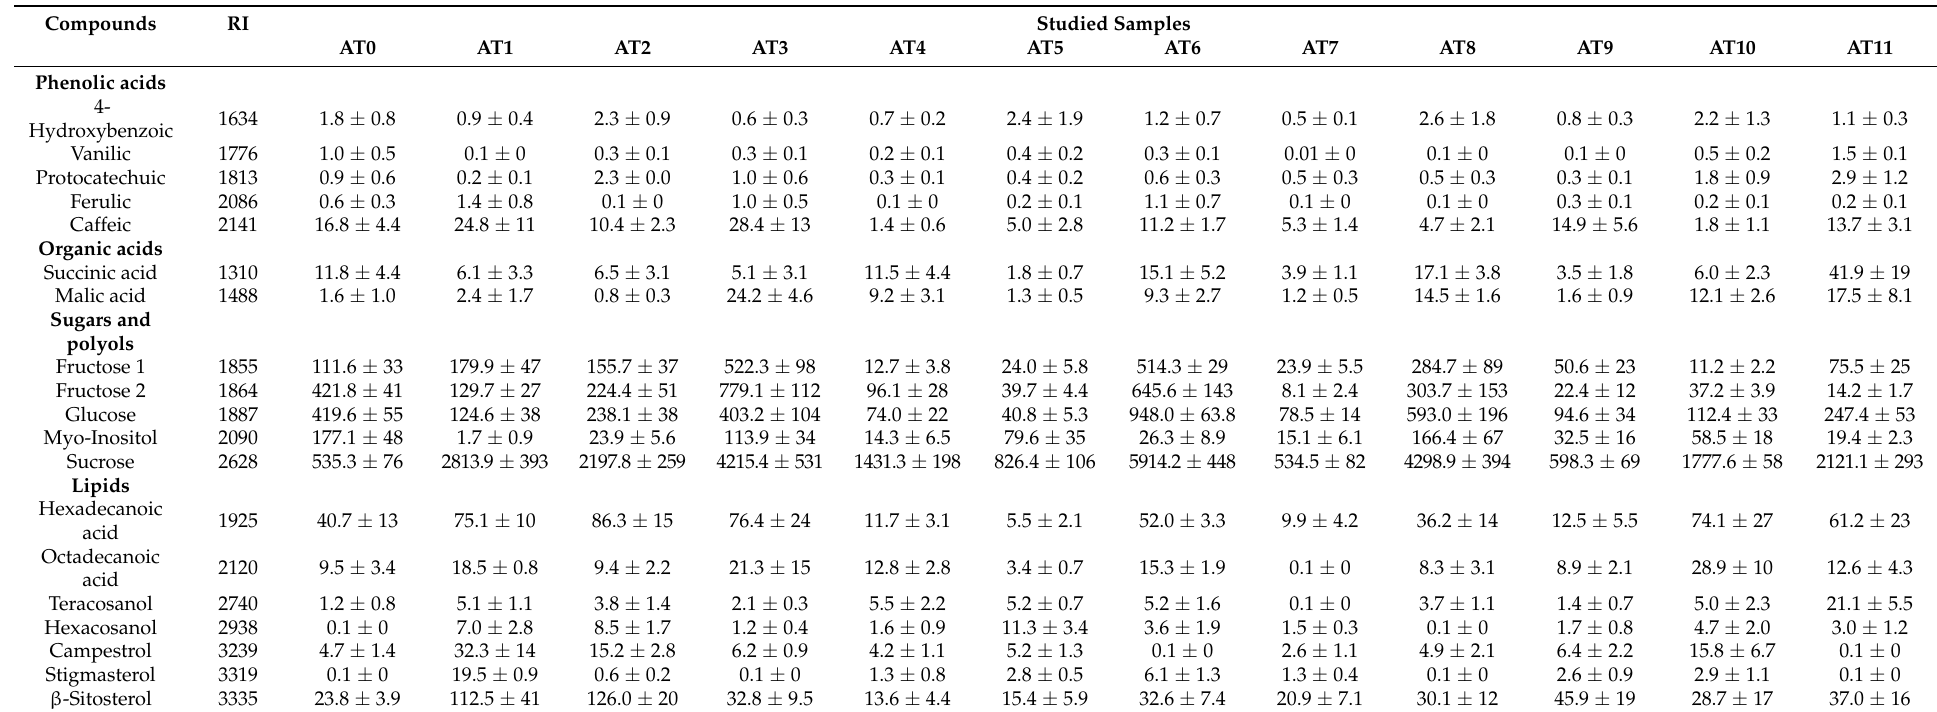
Table A1. Identified metabolites in the roots of A. tinctoria by GC/MS